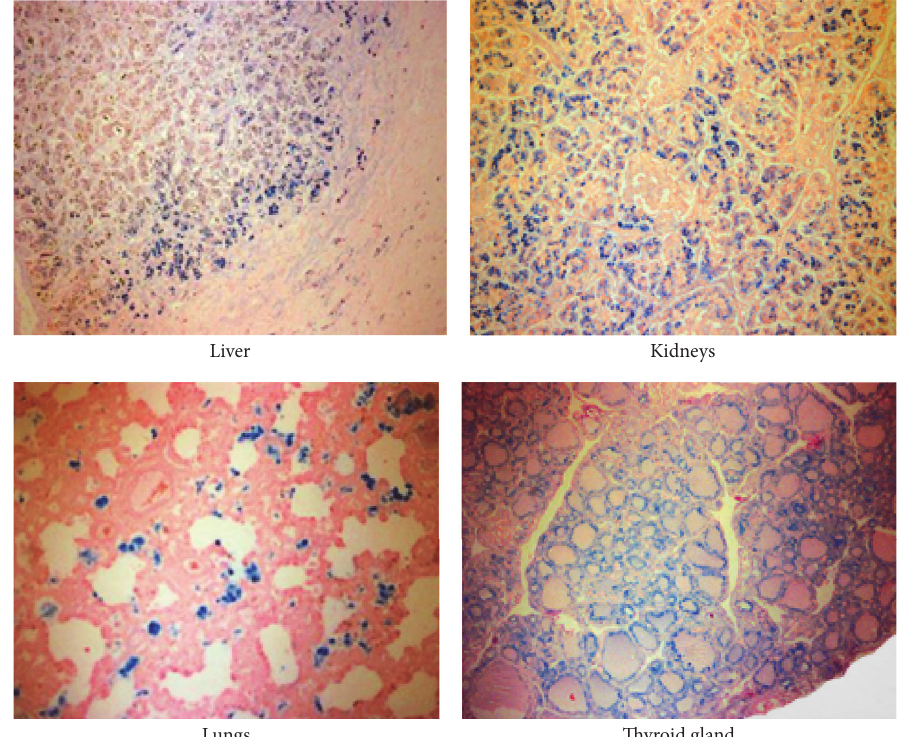
Figure 4: Perls’ stain showing hepatic and extrahepatic